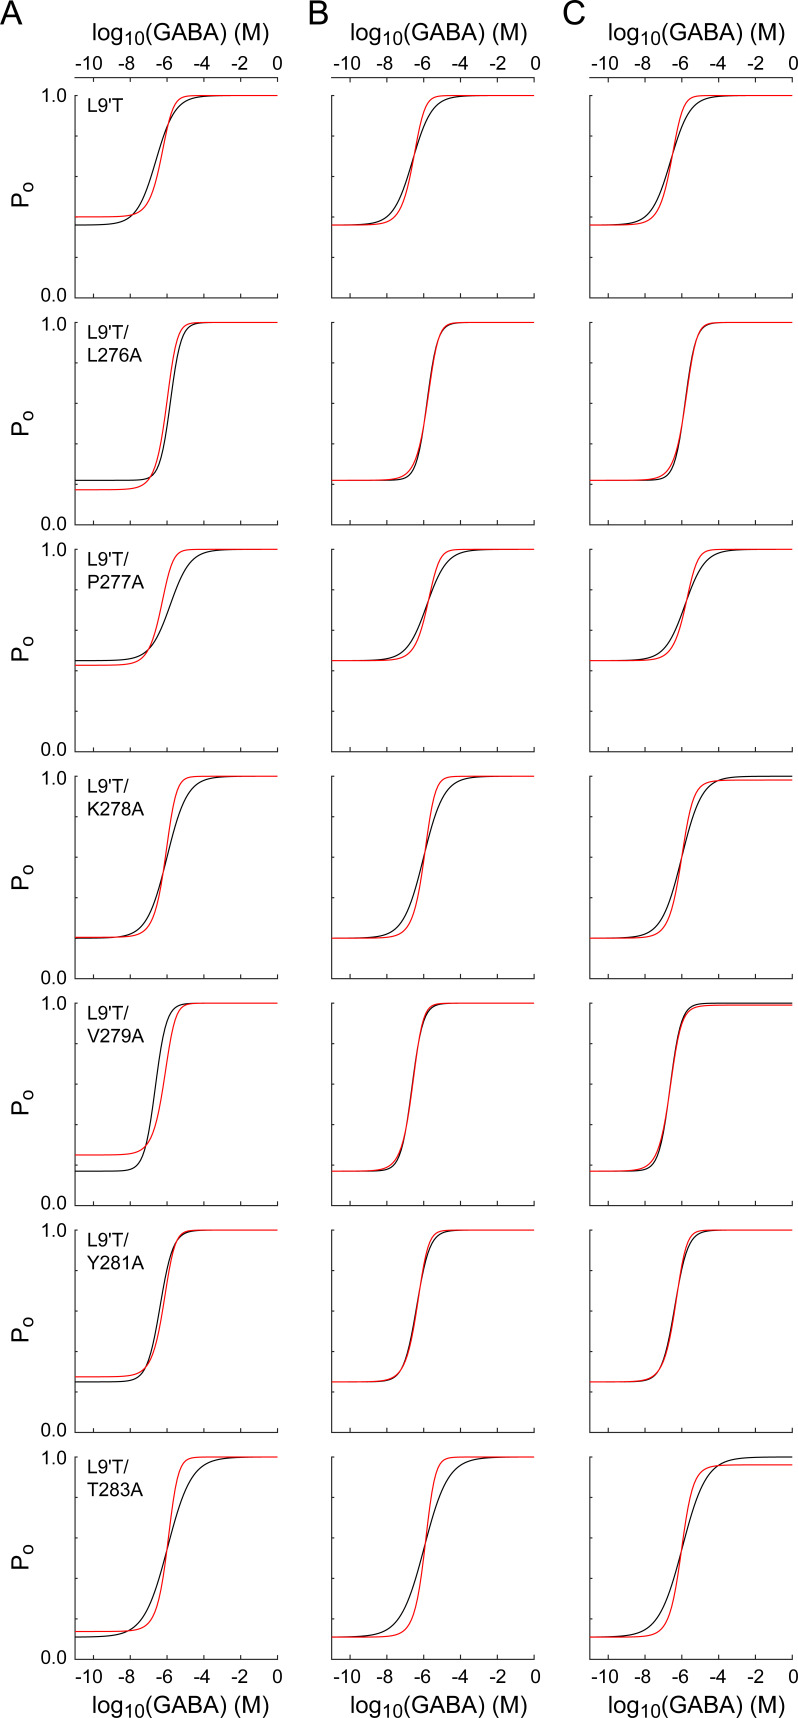
Estimated open probability (Po) from the data in Figure 2 (black) overlaid with simulations for the model in Figure 9A (red).(A) Model fits assuming mutations have identical affinities for GABA (KG = 190 μM, c constrained to 0.003). L9'T: L = 1.5; L9'T/L276A: L = 0.9; L9'T/P277A: L = 1.3; L9'T/K278A: L = 3.9; L9'T/V279A: L = 0.7; L9'T/Y281A: L = 2.6; L9'T/T283A: L = 6.3. (B) Model fits with constraints L =(1 – Po–unliganded)/Po–unliganded and c = 0.003. L9'T: KG = 90 μM; L9'T/L276A: KG = 390 μM; L9'T/P277A: KG = 670 μM; L9'T/K278A: KG = 240 μM; L9'T/V279A: KG = 50 μM; L9'T/Y281A: KG = 120 μM; L9'T/T283A: KG = 180 μM. (C) Same as (B) except c was allowed to vary. L9'T: KG = 270 μM, c = 0.001; L9'T/L276A: KG = 250 μM, c = 0.005; L9'T/P277A: KG = 500 μM, c = 0.004; L9'T/K278A: KG = 8 μM, c = 0.07; L9'T/V279A: KG = 3 μM, c = 0.04; L9'T/Y281A: KG = 270 μM, c = 0.001; L9'T/T283A: KG = 5 μM, c = 0.07.